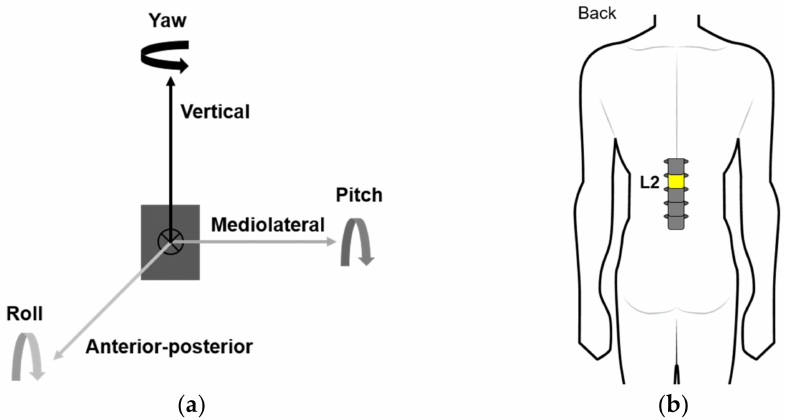
Figure 1. Information of the IMU: ( a ) definition 3-axis of the IMU; ( b ) attachment position of the IMU.